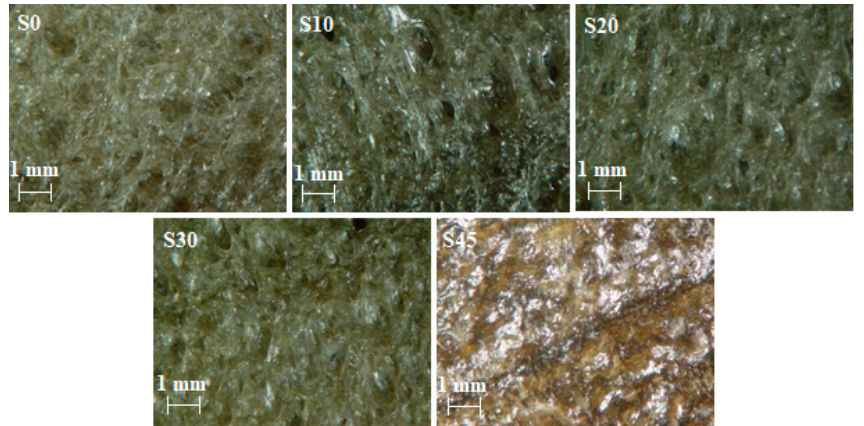
Figure 4. Optical microscopy images of the studied rubber samples.